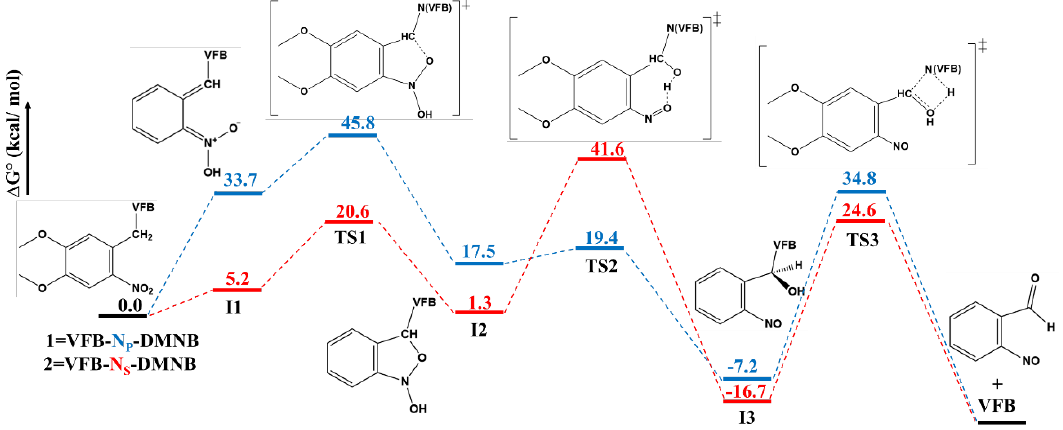
Figure 8. Energy profile of the photouncaging reactions of 1 and 2 . The Gibbs energy of the examined species was obtained from geometry optimization at the DFT/B3LYP /6-31G level of theory.